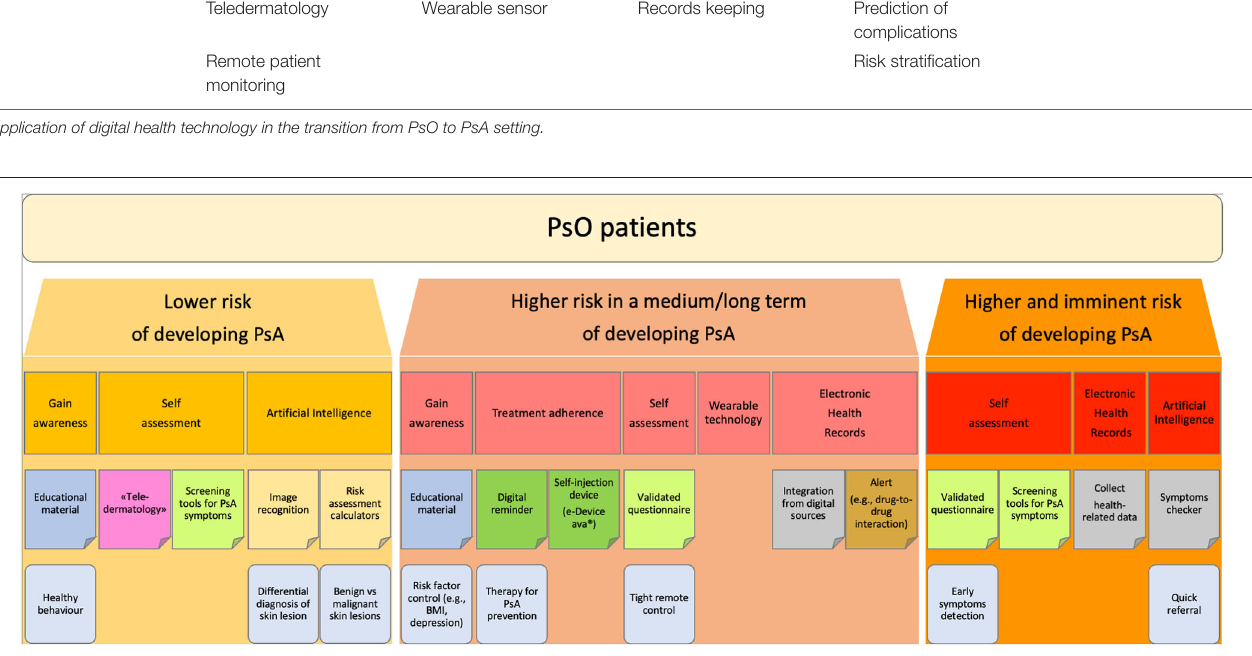
PsO patients have to gain awareness of their own inflammatory disease and the comorbidities related to